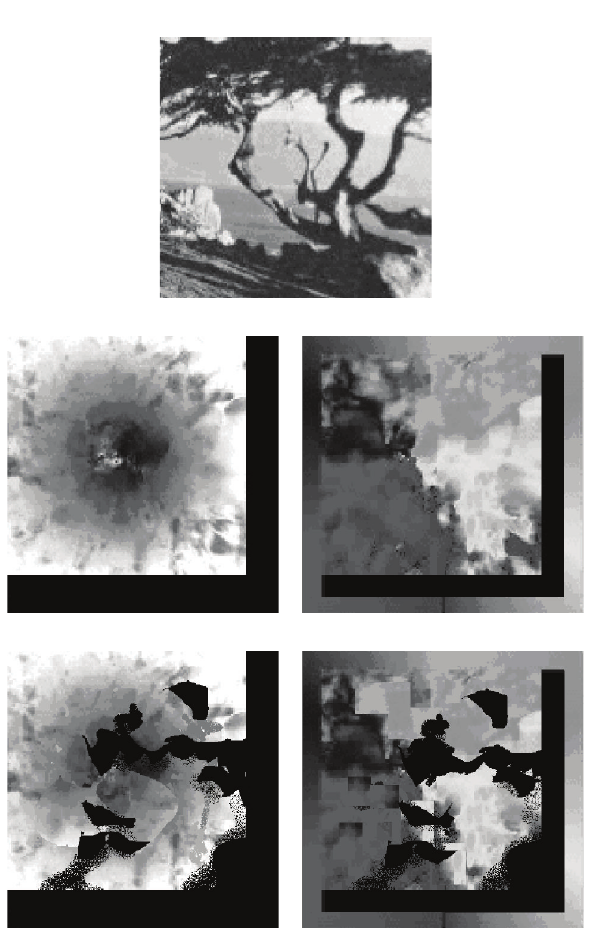
Figure 7: Some visual results corresponding to the software version versus the basic architecture (diverging tree sequence). Left hand indicates velocity modulus and right hand velocity phase.